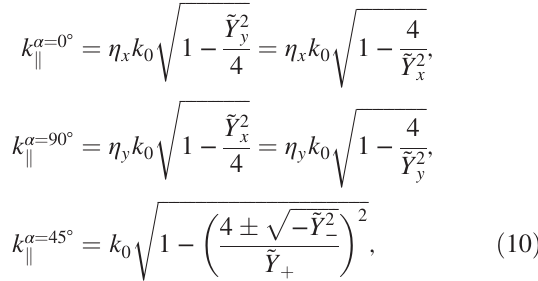
FIG. 4. Analytically calculated properties of an ideal resonant self-complementary metasurface. (a) Frequency dependence of the imaginary parts of admittance tensor components. The Lorentzian parameters are as follows: N 1 ¼ 1 , ˜ γ ¼ ˜ γ ¼ 0 . 03 . (b) – (d) Dispersion of surface waves localized at a self-complementary metasurface in different directions α ¼ 0 ° (b), 1 2 90° (c), and 45° (d). (e) – (j) Isofrequency contours of quasi-TE and quasi-TM surface modes in ð k angular frequencies ˜ ω ¼ 0 . 6 (e), ˜ ω ¼ 0 . 8 (f), ˜ ω ¼ 1 (g), ˜ ω ¼ 1 . 2 (h), ˜ ω ¼ 1 . 73 (i), and ˜ ω ¼ 2 (j). Here, we use the dimensionless units